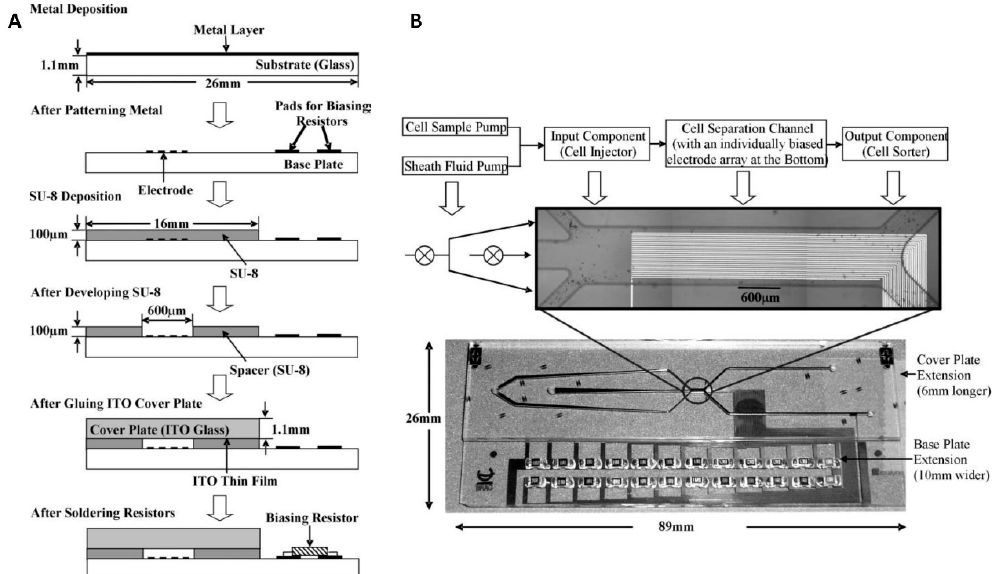
Figure 4. An isomotive DEP microfluidic device with parallel electrodes. ( A ) The fabrication process of the device. ( B ) Diagram of sample process sequence and photograph of the device with details showing the main channel for DEP. Reproduced with permission from [67], © 2007 Royal Society of Chemistry (RSC).